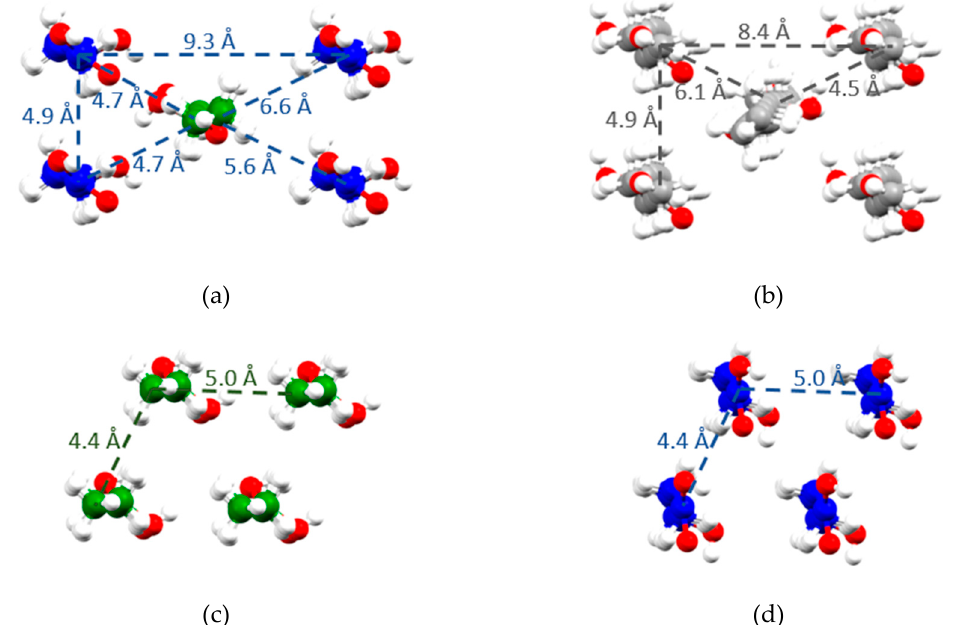
Figure 9. Packing of the lipid chains in the structures of ( a ) (R) -9-HSA crystallized from methanol, ( b ) (R) -12-HSA methyl ester [28], and ( c , d ) two crystallographically independent layers in the structure of (R) -9-HSA crystallized from melt. Different colors represent crystallographically independent molecules disposed in opposite directions. Dashed lines show distances between the carbon of the alkyl chain bearing the OH moiety, i.e., carbon 9 in panels ( a ), ( c ), and ( d ), and carbon 12 in panel ( b ).